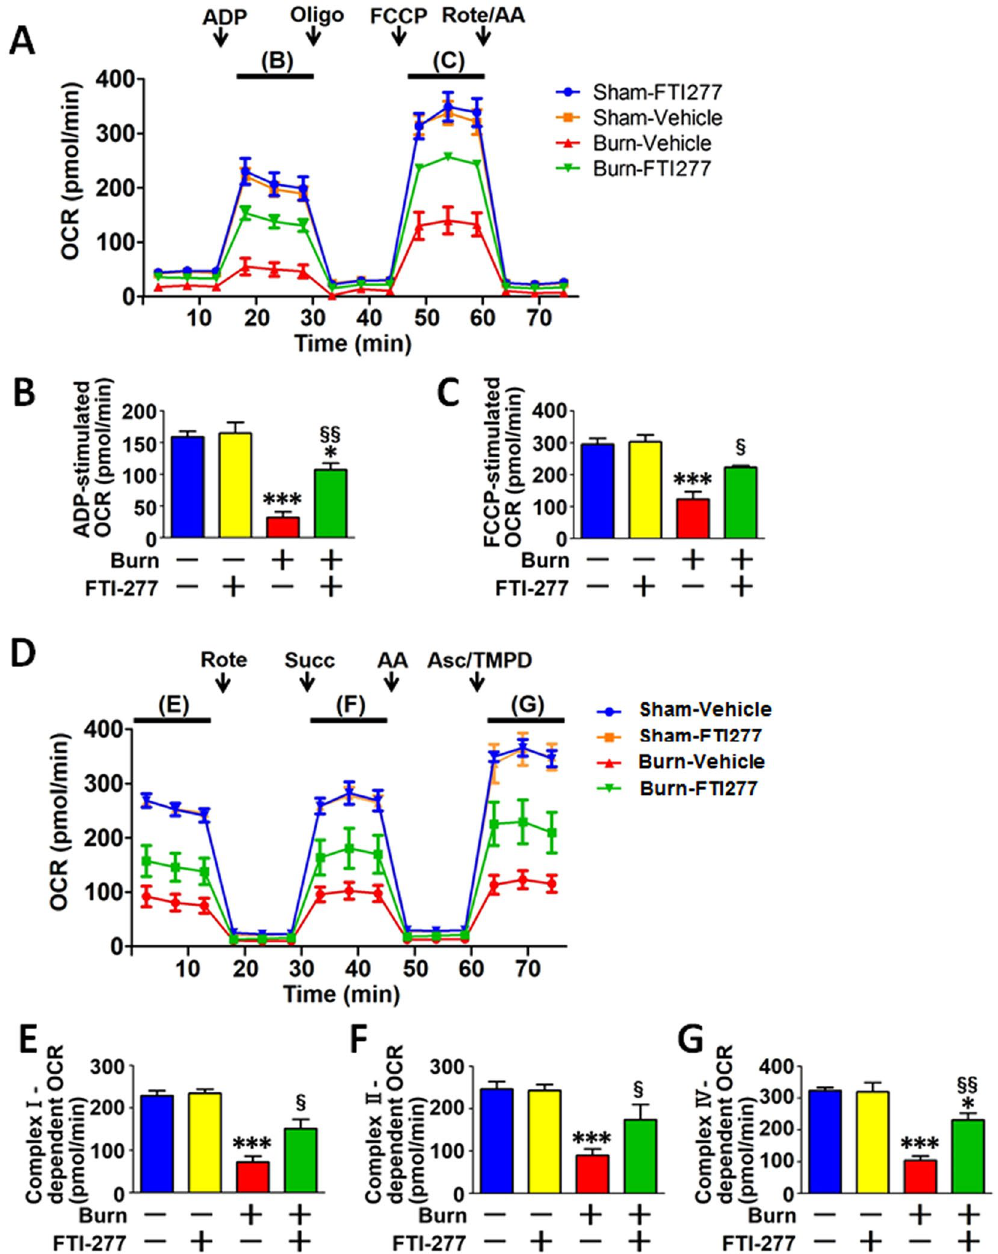
Figure 5. FTI-277 ameliorated burn-induced decreases in mitochondrial oxygen consumption rate (OCR) in skeletal muscle. ADP- and FCCP-stimulated OCRs were significantly decreased by burn injury at 3 days post-burn, both of which were ameliorated by FTI-277 treatment ( A – C ). Similarly, complex I-, complex II-, and complex IV-dependent OCRs were significantly decreased at 3 days after burn injury, all of which were ameliorated by FTI-277 ( D – G ). The time points, in which ADP- ( B ), FCCP- ( C ), complex I- ( E ), complex II- ( F ), and complex IV- ( G ) dependent OCRs were evaluated, are indicated in A and C. ADP: adenosine diphosphate, Oligo: oligomycin, FCCP: carbonyl cyanide 4-(trifluoromethoxy) phenylhydrazone, Rote: rotenone, AA: antimycin A, Succ: succinate, Asc: ascorbate, TMPD: N, N, N9, N9-Tetramethylp- phenylenediamine. * P < 0.05, *** P < 0.001 vs. sham-burn groups, § P < 0.05, §§ P < 0.01 vs. vehicle-treated burn group. n = 4 mice per